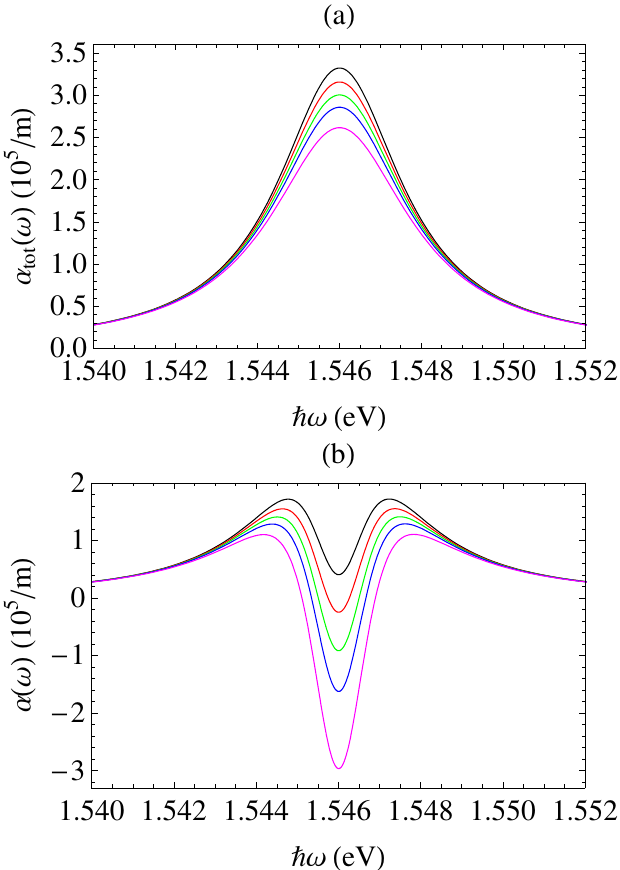
Figure 5. (Color online) The same as in Figure 2 but for the electric field polarized along the x axis.